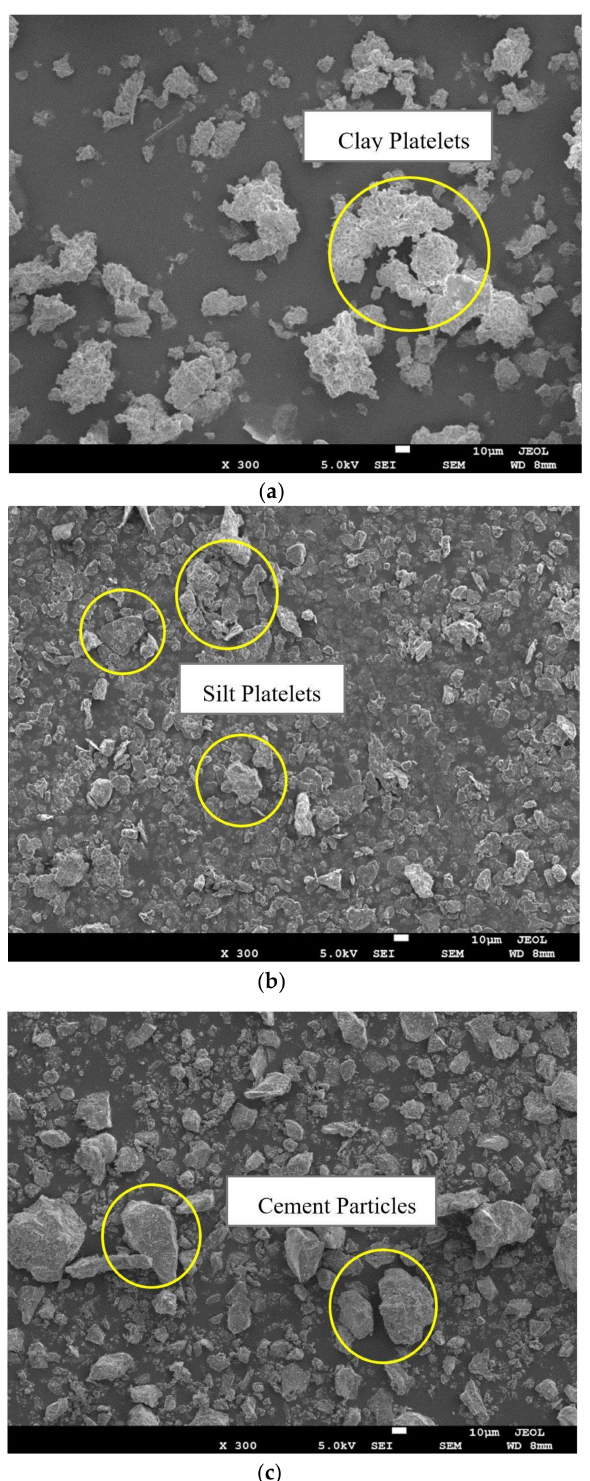
Figure 1. SEM images of soils and cement used in this study ( a ) Port of Brisbane soft soil; ( b ) Kaolin Soil (KM25); ( c ) Ordinary Portland Cement (300 times